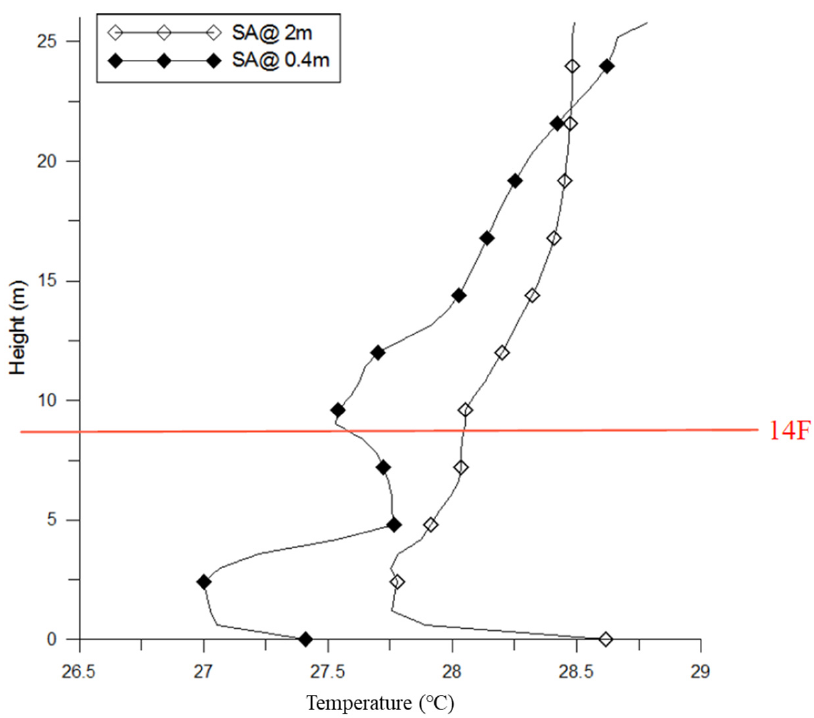
Figure 18. Vertical temperature distribution of atrium with varying SA height.